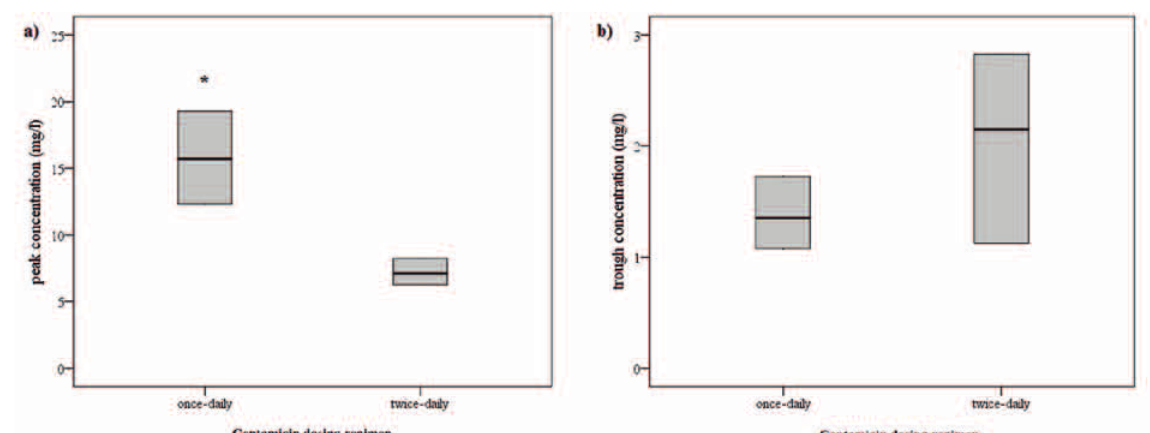
Figure 1. Inter-quartile range (lower, median, upper quartile) of: a) peak and b) trough gentamicin concentrations depending on the dosing